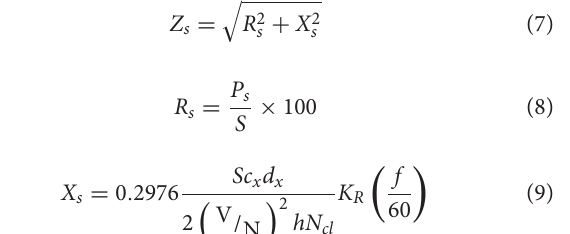
TABLE 1 | Transformer deformation levels and their corresponding R XY values (Wimmer et al., 2007; Kraetge et al., 2008; Bagheri et al., 2013). Deformation level